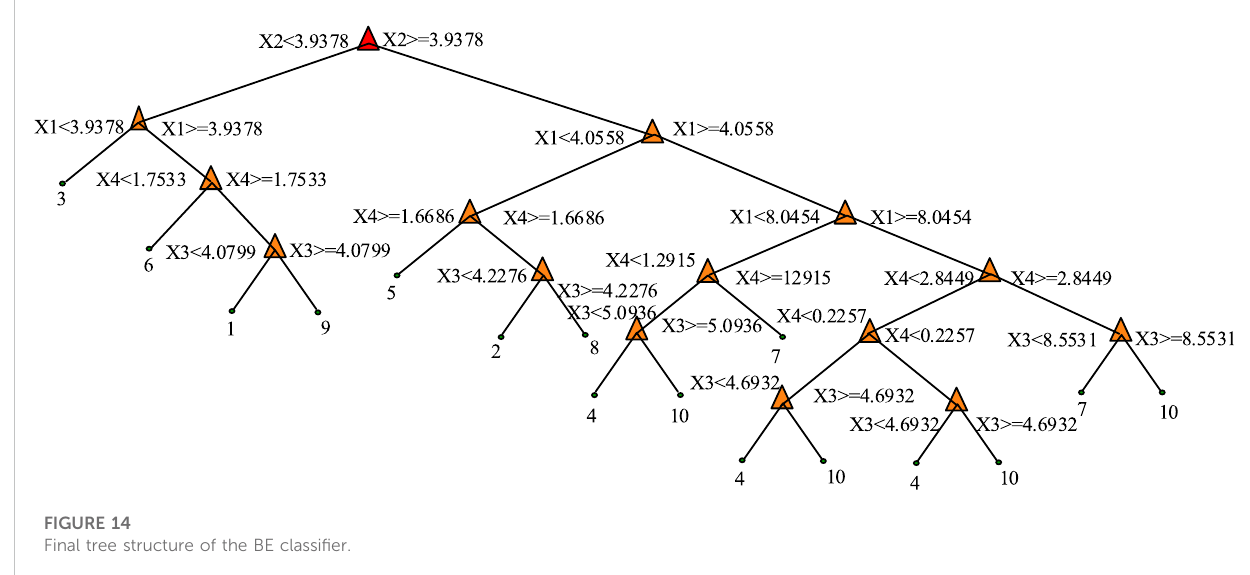
FIGURE 14 Final tree structure of the BE classi fi er.